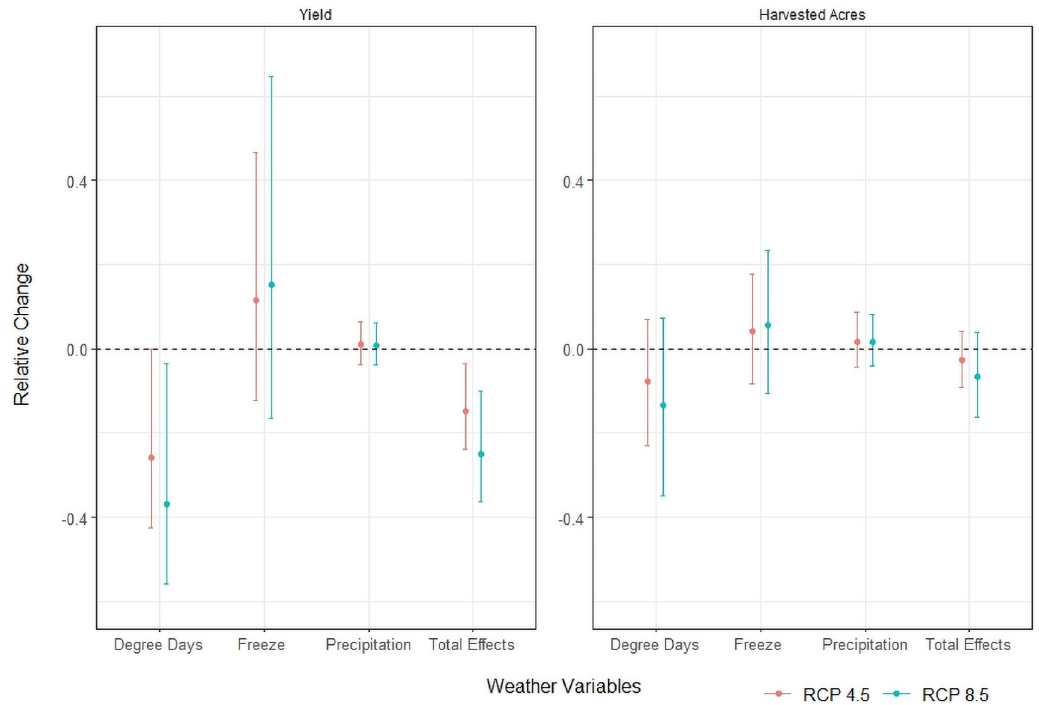
Fig 4. Decomposition of production losses by drivers of change. The change and in projected winter wheat yield (A) or proportion of acres harvested (B) at mid-century (2034–65) using a change in each type of climate variable. The dot indicates the mean effect and whiskers show the 95% confidence interval. Results use ensemble average climate projections and uncertainty is from the uncertainty of the regression model estimates.